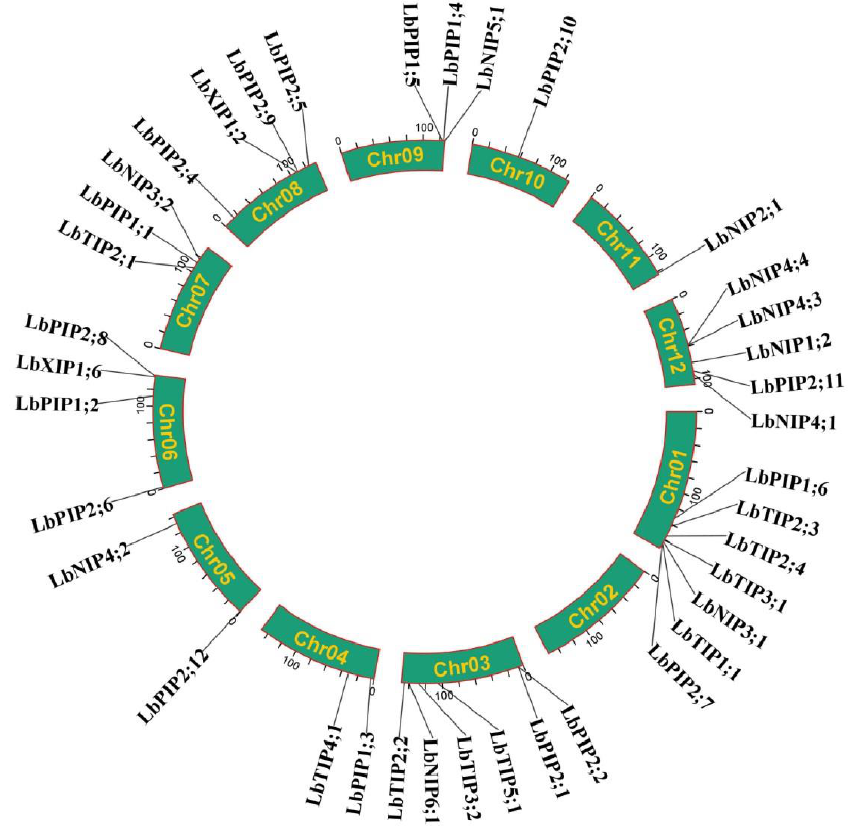
Figure 2. Chromosomal distribution of LbAQP genes.